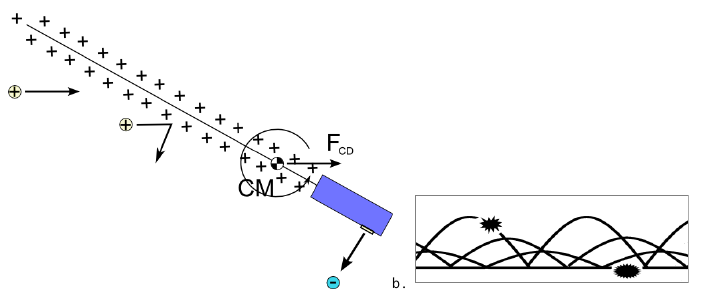
Fig. 4. (a) The situation with a positively charged tether; charged particles interacting with it, creating the Coulomb drag force F CD parallel to the particle stream experienced by the whole spacecraft system (tether and spacecraft), while the tether itself is kept taut by the rotation of the spacecraft around its common centre of mass CM (not to scale). (b) Redundant strands ensure a level of tolerance to tearing (Sepp¨anen et al., 2011).